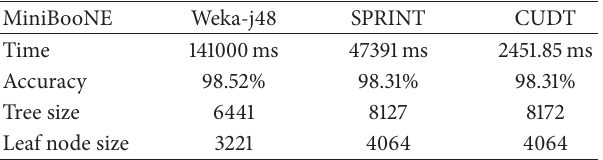
Figure 19: Execution time of each Level on MiniBooNE. Table 4: Results of